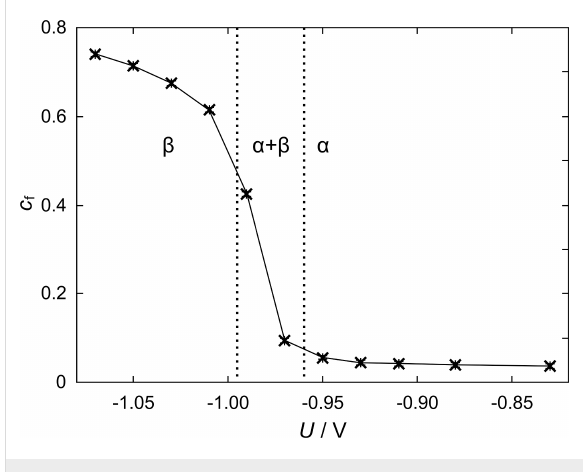
Figure 4: Atomic ratio of hydrogen and palladium c f (H:Pd) plotted as function of the polarisation potential U for nanoporous palladium in 1 M KOH, dotted vertical lines separate the regimes of PdH α , PdH β and phase coexistence.